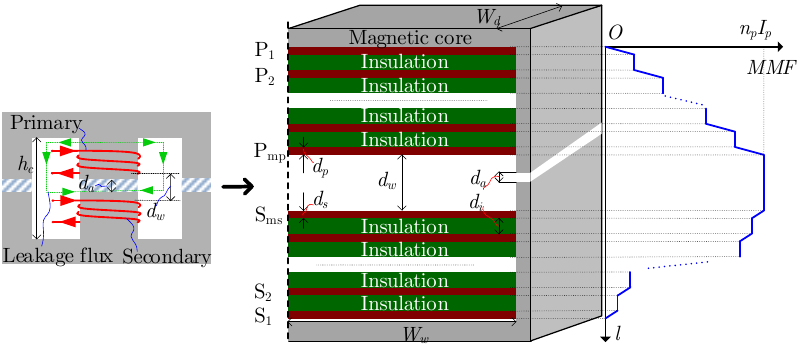
Figure 3. General winding configuration and magneto-motive force (MMF) distribution.